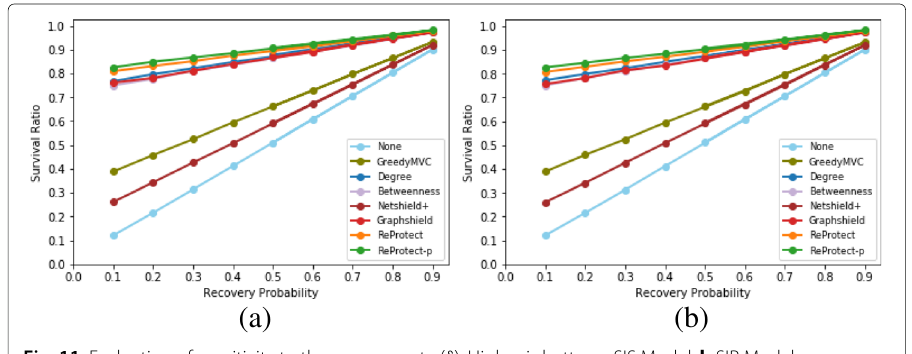
Fig. 11 Evaluation of sensitivity to the recovery rate ( δ ). Higher is better. a SIS Model. b SIR